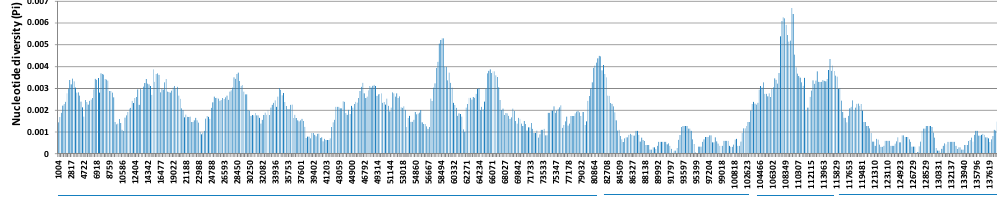
Figure 3. Nucleotide diversity (Pi) from the sliding window analysis of 25 complete Avena chloroplast genome assemblies (window length: 2000 bp, step size 200 bp). X-axis: position of the window midpoint, Y-axis: nucleotide diversity within each window.